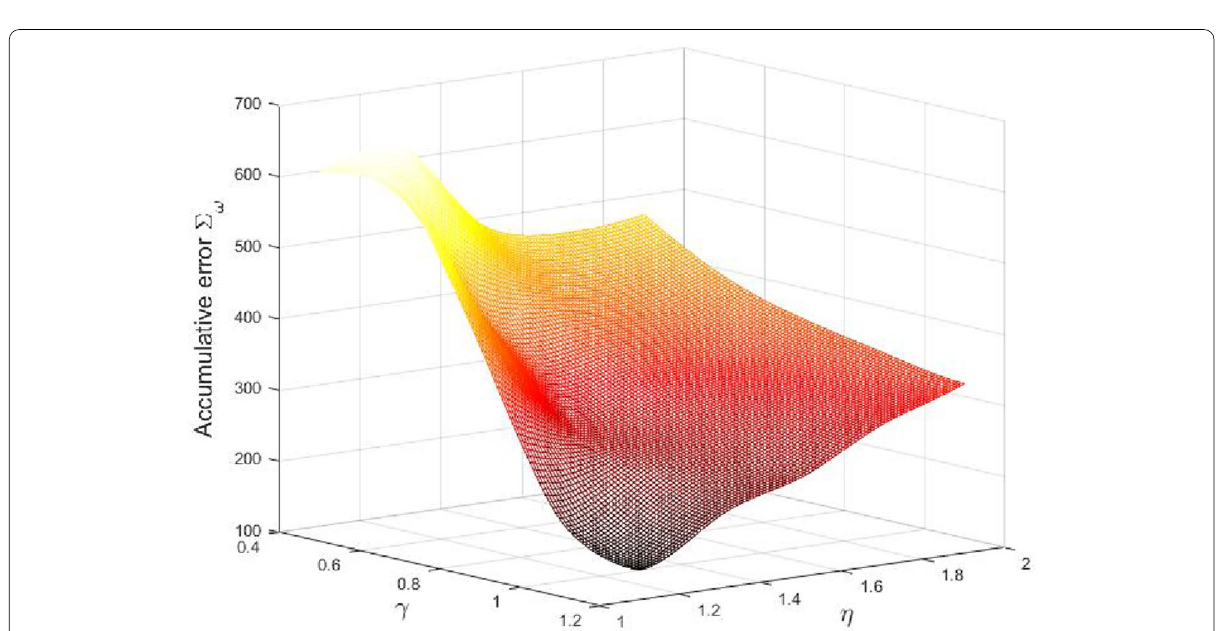
Figure 10 Relation between accumulative error � ω , γ and